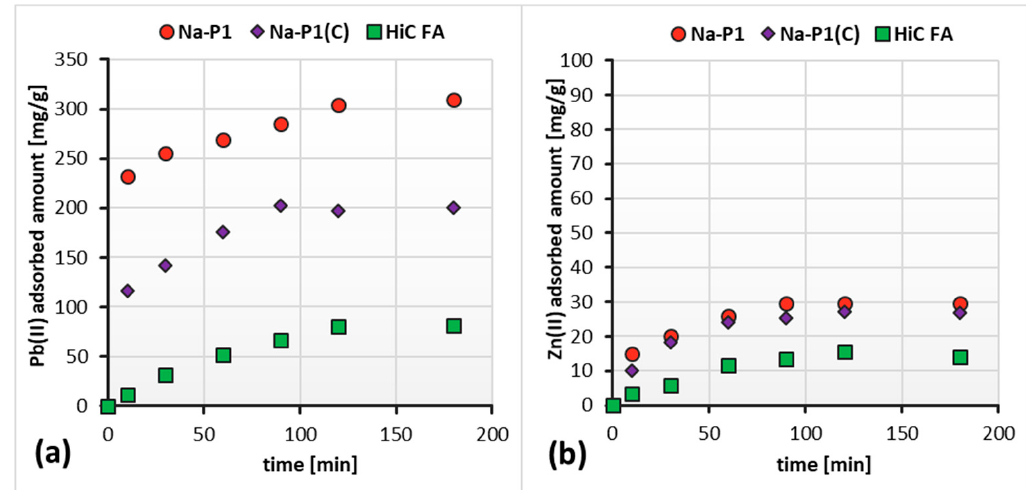
Figure 9. Adsorbed amounts of Pb(II) ( a ) and Zn(II) ( b ) on the HiC FA, Na ‐ P1 and Na ‐ P1(C) surfaces in the mixed systems as a function of time, at pH 5.